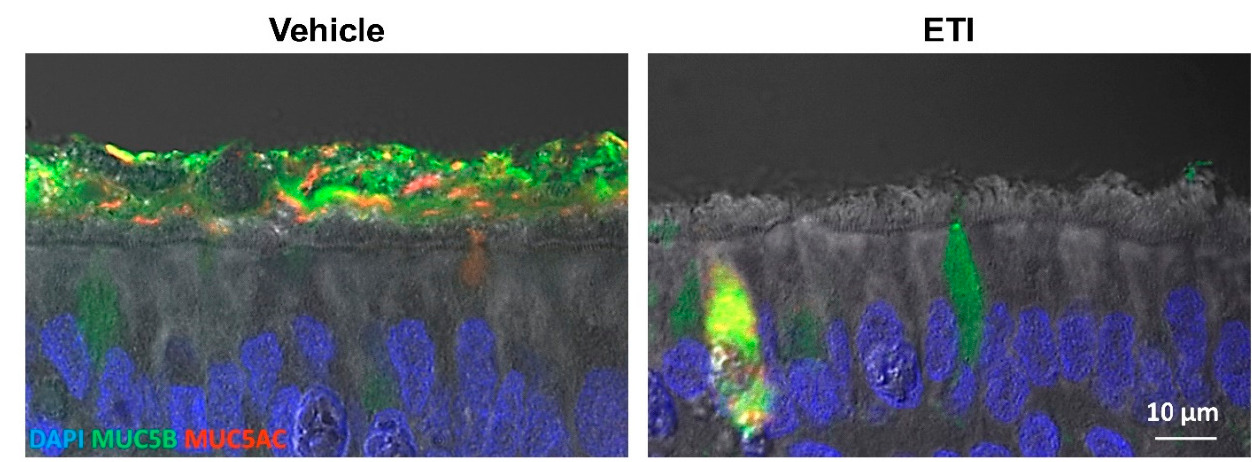
Figure 3. Effects of ETI treatment on mucus removal from the cell surfaces. Primary HBE cells homozygous for F508del were treated for 3 days with 0.06% dimethyl sulfoxide (DMSO/vehicle) or 3 µ M VX-661, 2 µ M VX-445, and 1 µ M VX-770 (ETI). Cells were washed for 15 min with PBS, fixed with 4% PFA, and processed for immunohistochemistry. Representative images of histological sections stained with MUC5AC (red), MUC5B (green), DAPI (blue), and DIC overlay.